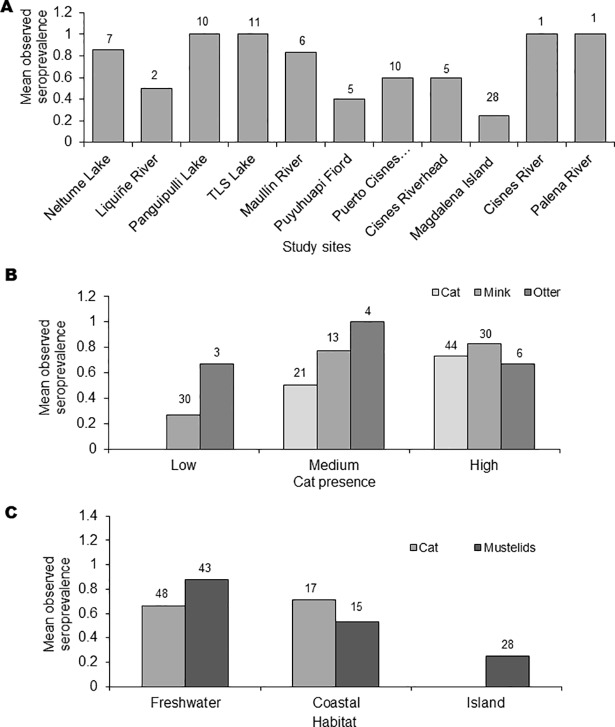
Effects of landscape variables on seroprevalence.A) Observed seroprevalence in mink and otter by study site. B) Observed seroprevalence by degree of presence of domestic cat. C) Observed seroprevalence by habitat. * Number above bars indicate sample size. Y axis show mean seroprevalence.